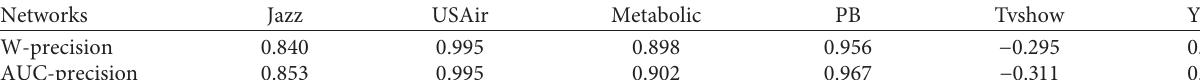
Table 5: The correlation coefficient between W-index score and precision score and that of AUC score and precision score on six networks without considering the CN-W, LHN-W, RA-W, and WIC predictors.